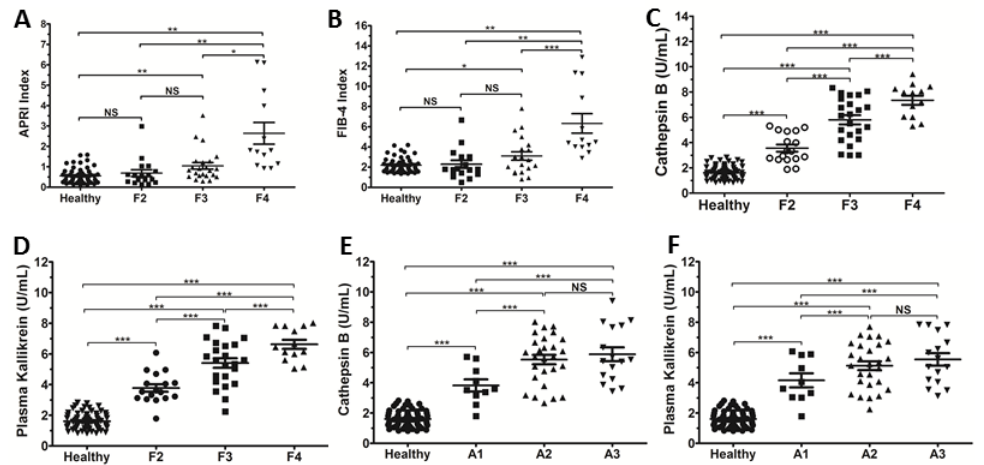
Figure 1. Relationship between serum levels of cathepsin B (Cat B) and plasma kallikrein (PKa) with the METAVIR scoring system for hepatic fibrosis and inflammatory activity in CHC patients and healthy controls (HCs). ( A ) APRI score in relation to hepatic fibrosis in patients with HCV infection. APRI of HCs (0.55 ± 0.05; N = 71), F2 (0.69 ± 0.17; N = 17), F3 (1.04 ± 0.16; N = 23), F4 (2.64 ± 0.53; N = 13). ( B ) FIB4 score in relation to hepatic fibrosis in patients with HCV infection. FIB4 score of HCs (2.21 ± 0.09; N = 71), F2 (2.30 ± 0.39; N = 17), F3 (3.11 ± 0.41; N = 23), F4 (6.33 ± 0.96; N = 13). ( C ) Serum Cat-B levels in relation to hepatic fibrosis in CHC patients. Cat-B levels of HCs (1.61 ± 0.06 U/mL; N = 71), F2 (3.61 ± 0.26 U/mL; N = 23), F3 (5.30 ± 0.33 U/mL; N = 30), F4 (7.14 ± 0.31 U/mL; N = 17). ( D ) PKa levels in relation to hepatic fibrosis in CHC patients. PKa levels of HCs (1.61 ± 0.06 U/mL; N = 71), F2 (3.77 ± 0.24 U/mL; N = 17), F3 (5.40 ± 0.31 U/mL; N = 23), F4 (6.62 ± 0.30 U/mL; N = 13). ( E ) Serum Cat-B levels in relation to inflammatory activity in CHC patients. Cat-B levels of HCs (1.61 ± 0.06 U/mL; N = 71), A1 (3.82 ± 0.40 U/mL; N = 10), A2 (5.26 ± 0.31 U/mL; N = 27), A3 (5.88 ± 0.46 U/mL; N = 16). ( F ) PKa levels in relation to inflammatory activity in CHC patients. PKa levels of HCs (1.61 ± 0.06 U/mL; N = 71), A1 (4.16 ± 0.46 U/mL; N = 10), A2 (5.12 ± 0.29 U/mL; N = 27), A3 (5.54 ± 0.41 U/mL; N = 16). The results are